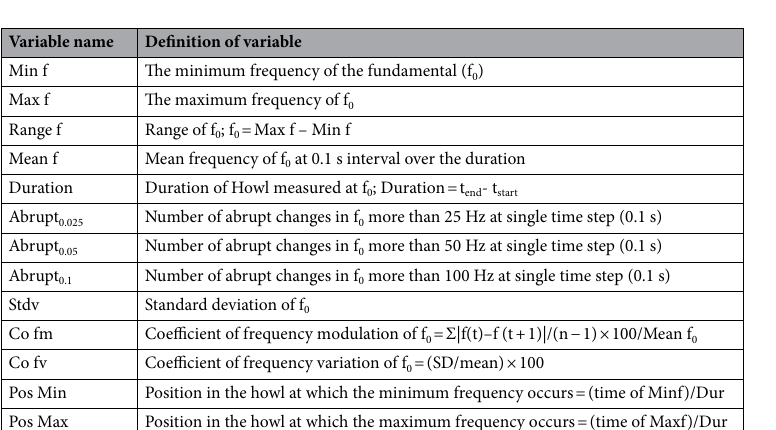
Figure 2. Spectrogram of Gangewadi Wolf howl (160203-001_Gangewadi2_A5) showing how different variables were measured.